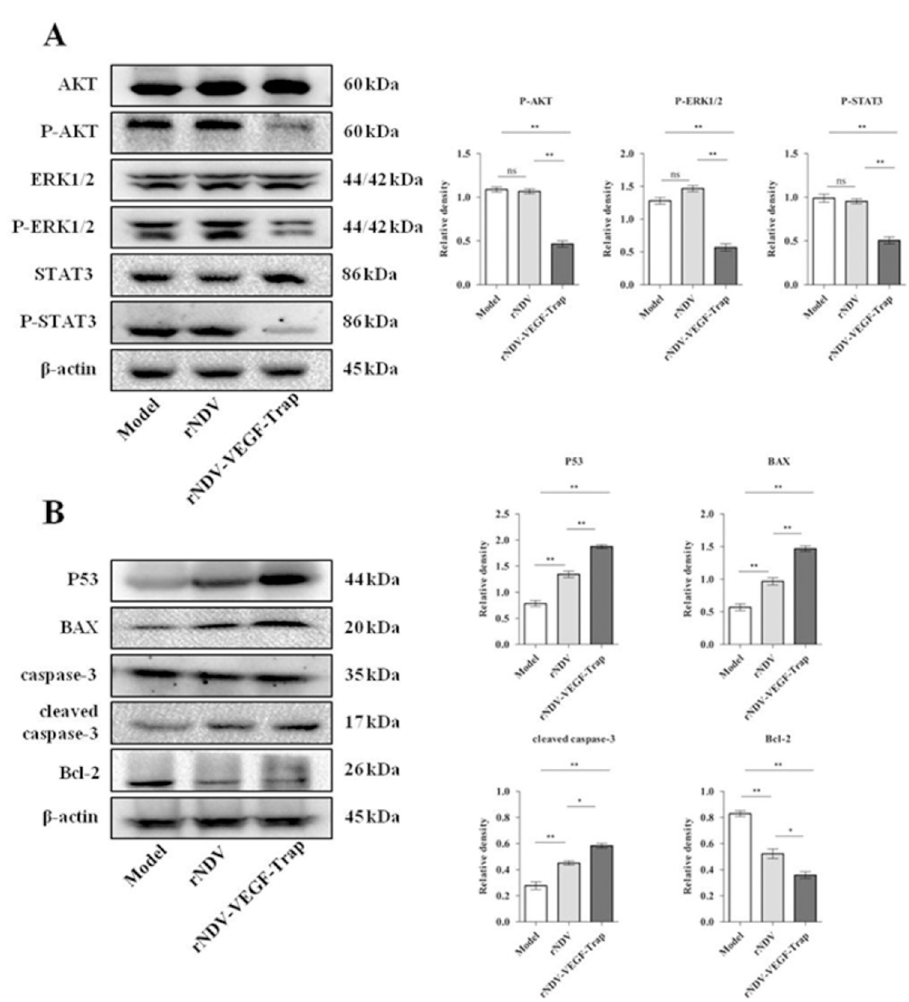
Fig 5. rNDV-VEGF-Trap inhibits the phosphorylation of the VEGF signaling pathway related proteins AKT, ERK1/2, STAT3 and mediates the expression of the apoptosis-related proteins P53, Bcl-2, BAX, caspase-3. Six- week-old female BALB/c mice were injected with 10 6 CT26 cells in the right groin. When the tumor size reached about 100 mm 3 , the mice were intratumorally treated with rNDV or rNDV-VEGF-Trap at 10 7 pfu. The mice were euthanized and necropsy was performed after 15 days of treatment. CT26 tumor tissue (each group 0.5 g) was homogenized, the supernatant was collected after centrifugation. The expression of the VEGF signaling pathway related proteins and the apoptosis-related proteins in supernatant were detected by Western blot. (A) Treatment with rNDV-VEGF-Trap significantly reduced the expression levels of P-AKT, P-ERK and P-STAT3 compared with rNDV. The relative protein expression levels were expressed as the ratio of P-AKT to AKT, P-ERK1/2 to ERK1/2 and P-STAT3 to STAT3 (arbitrary units). (B) rNDV-VEGF-Trap significantly increased the expression levels of P53, BAX and cleaved caspase-3 and significantly downregulated the expression level of Bcl-2 compared with rNDV. β -actin was used as reference to quantify the protein bands by densitometry using ImageJ software. All data were expressed as mean ± SEM, N = 3, (ns, no significant; � P < 0.05; �� P < 0.01) compared to the